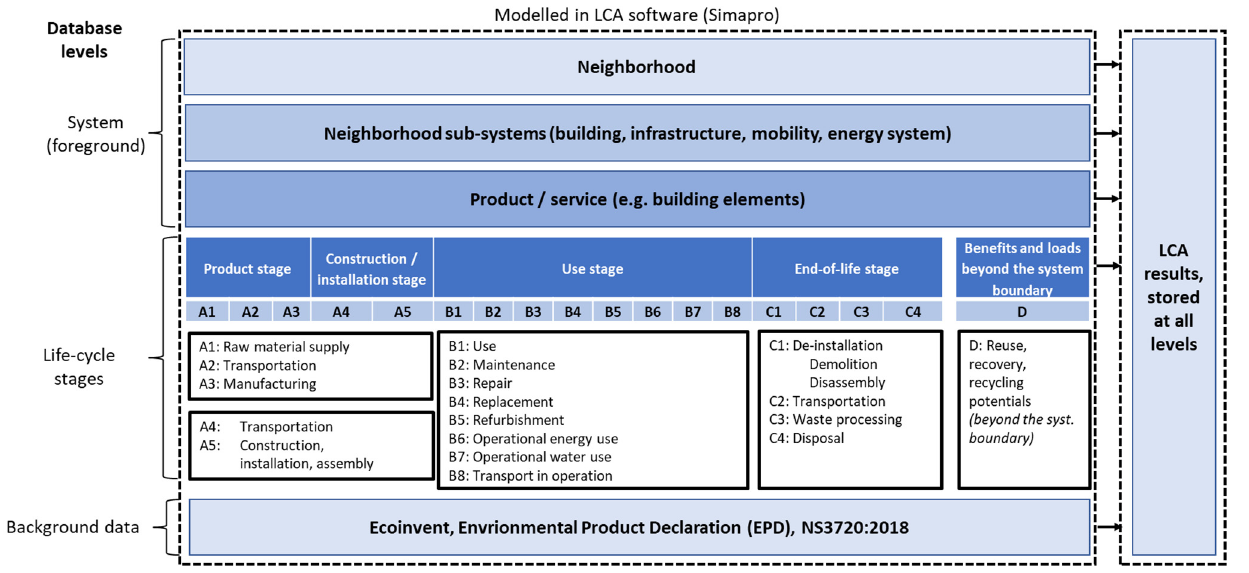
Figure 3. Outline of a general database structure, life cycle stages, and systems of interest. Life-cycle stages from EN15804 [11] and NS3720 [12].